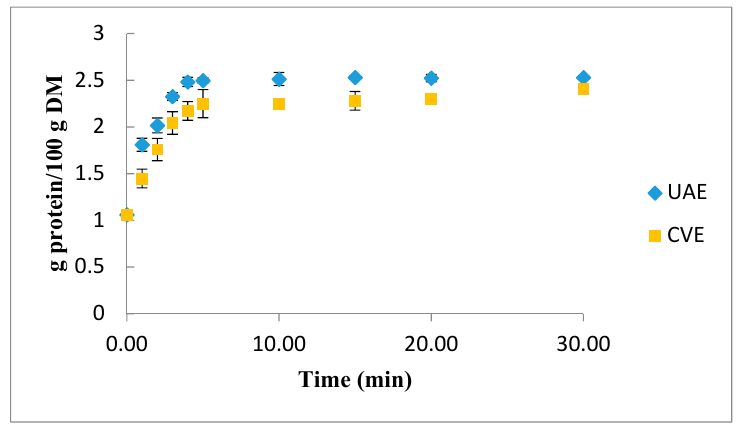
Figure 4. Comparison between conventional (CE) and ultrasound assisted extraction (UAE).